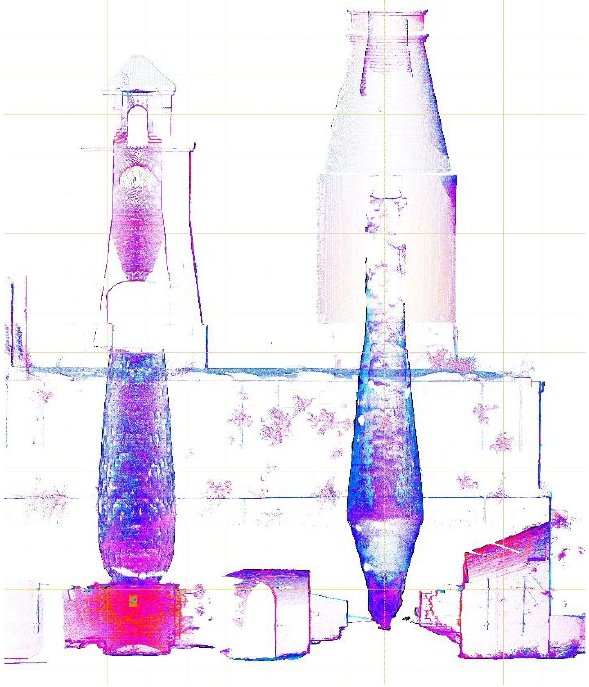
Figure 6: point cloud database sections of the two furnaces analysed.